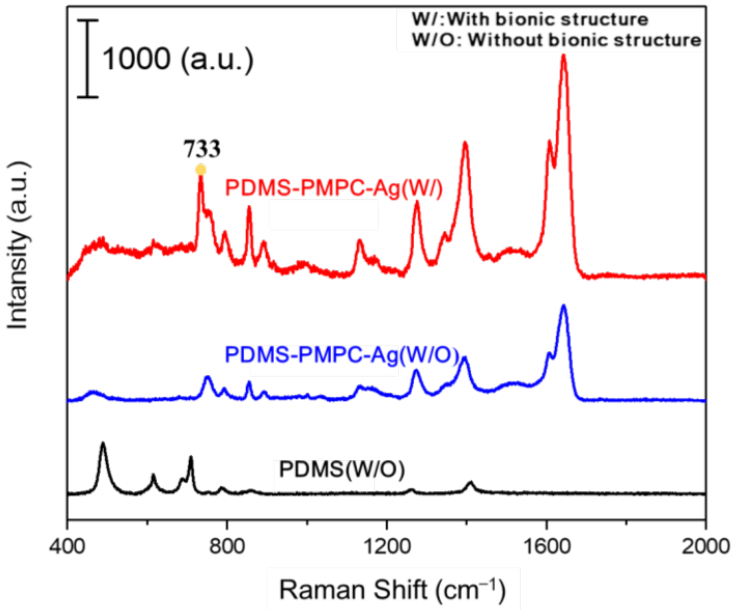
Figure 15. Raman spectrum of PDMS without (W/O) bionic structure, PDMS-PMPC-Ag without (W/O) bionic structure, and PDMS-PMPC-Ag with (W/) bionic structure.